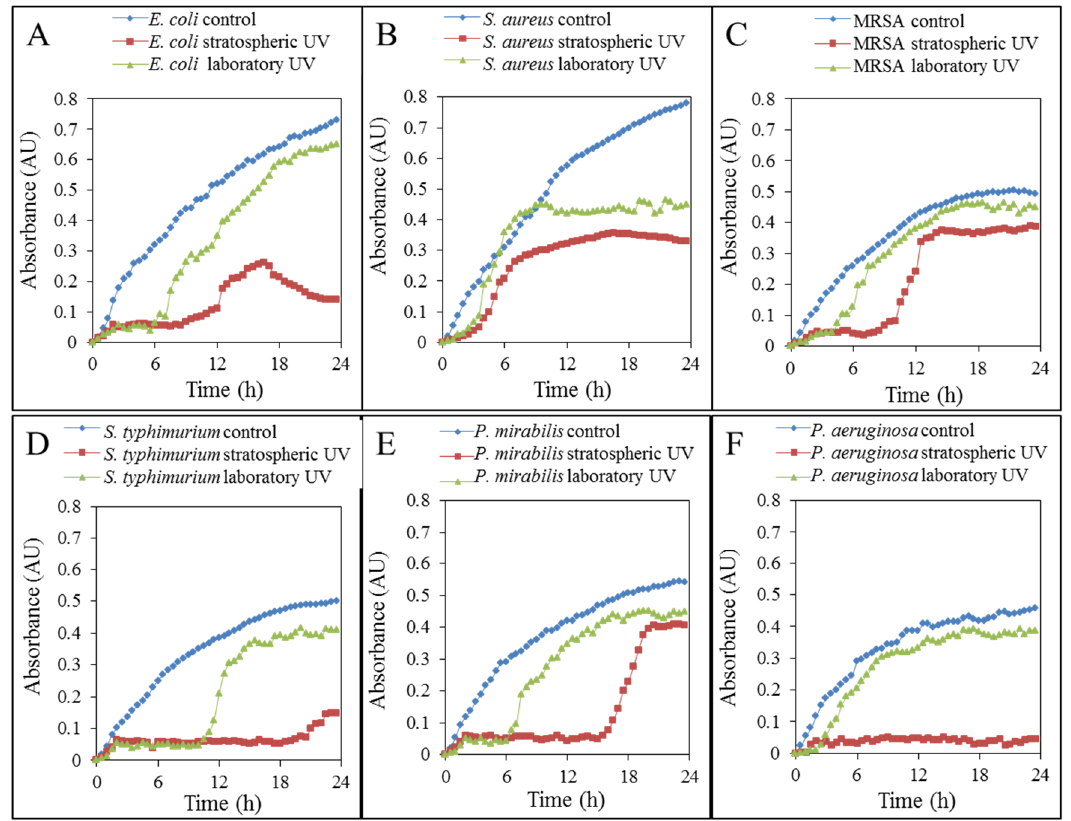
Figure 2. Growth properties of the bacteria ( A ) E. coli , ( B ) S. aureus , ( C ) MRSA, ( D ) S. typhimurium , ( E ) P. mirabilis and ( F ) P. aeruginosa ) without UV exposure,